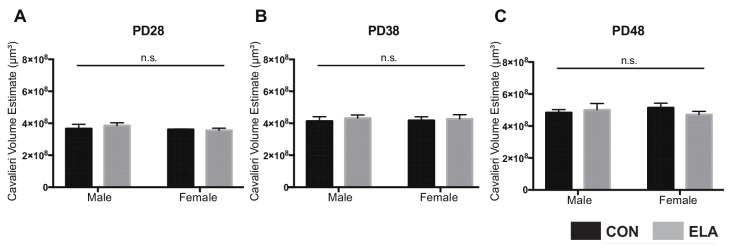
No effects of sex or rearing condition on BLA volume.There were no significant effects of sex or rearing on basolateral amygdala (BLA)volume as estimated via Cavalieri probe across the rostral-caudal extent of the structure in PD28 (A), PD38 (B), or PD48 (C) rats. n = 4 per group. As such, data presented in panels A, B, and C were collapsed across sex and rearing condition for each age group to determine average BLA volume (n = 16 per age). n.s. (non-significant).